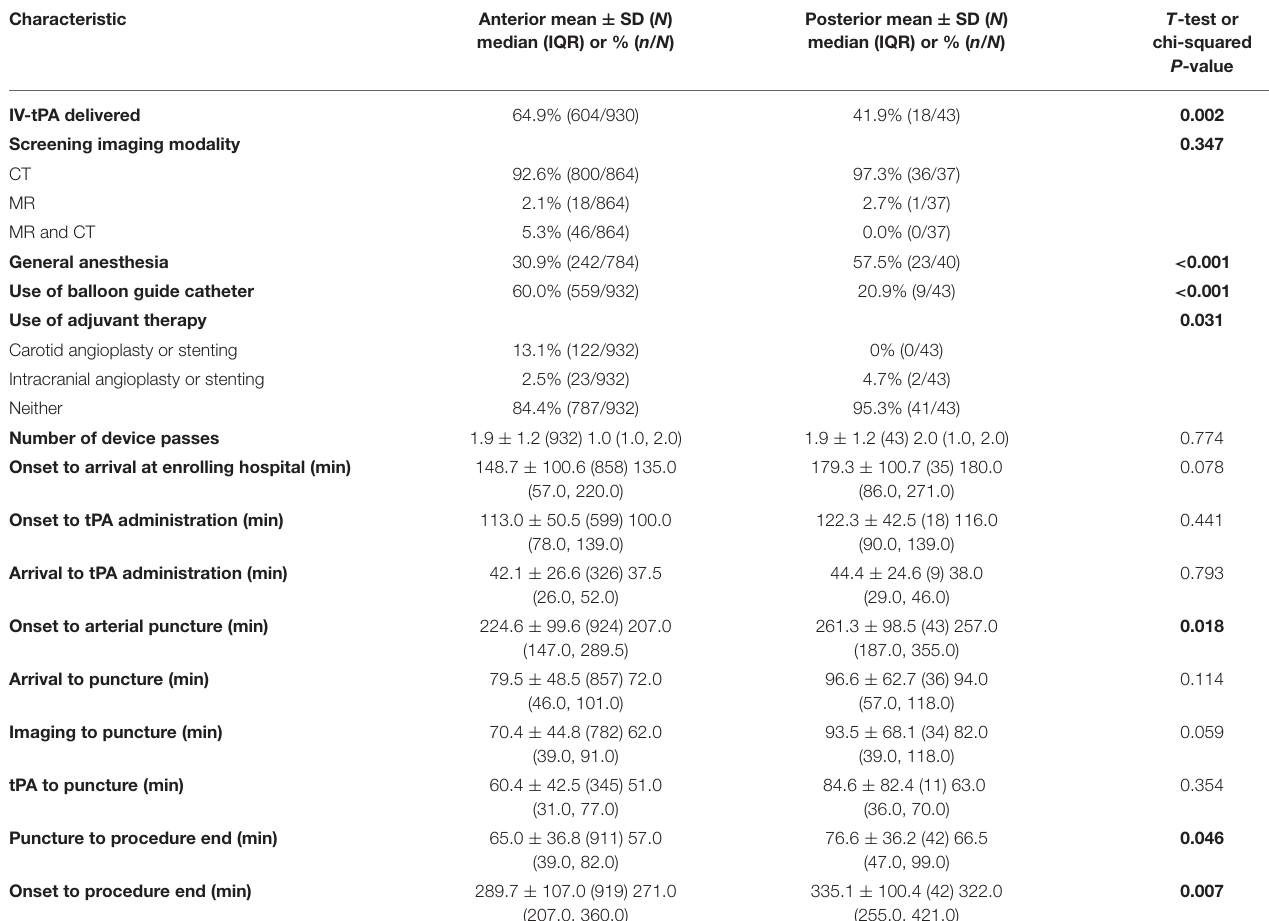
TABLE 2 | Procedure and workflow characteristics. Characteristic